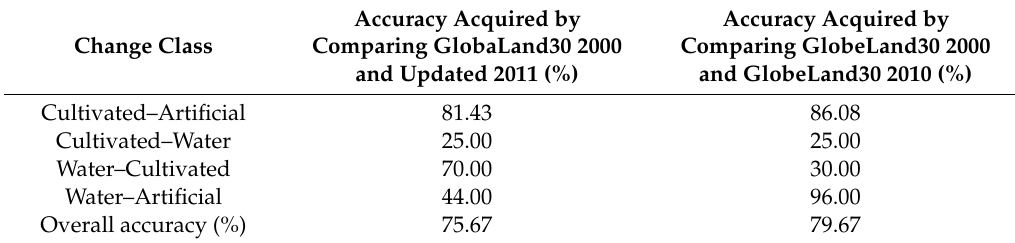
Table 8. Multiclass accuracy